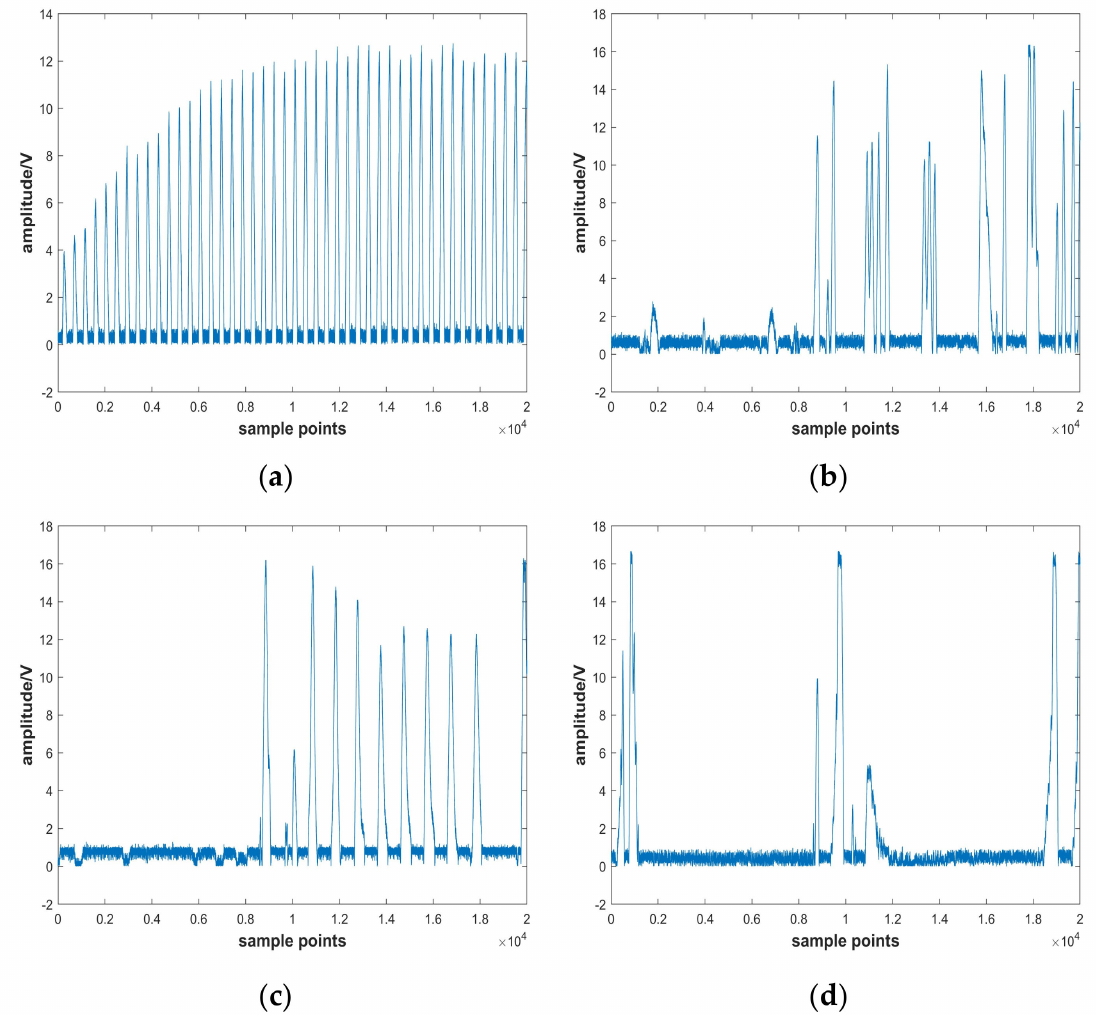
Figure 2. Fuze output time–domain signals under the action of the target and jamming. ( a ) Target action output signal; ( b ) Noise AM frequency sweep action output signal; ( c ) Sine AM frequency sweep action output signal; ( d ) Square AM frequency sweep action output